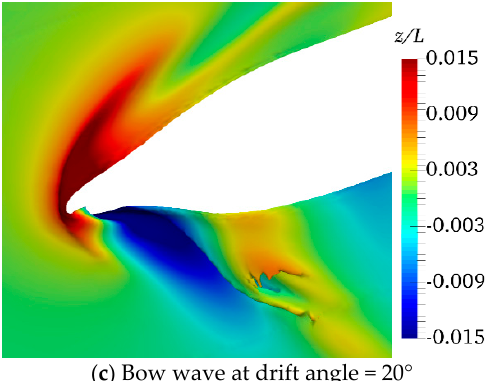
Figure 6. Free surface: ( a ) free surface in CASE DA4; ( b ) free surface in CASE DA20; ( c ) bow wave in CASE DA20.